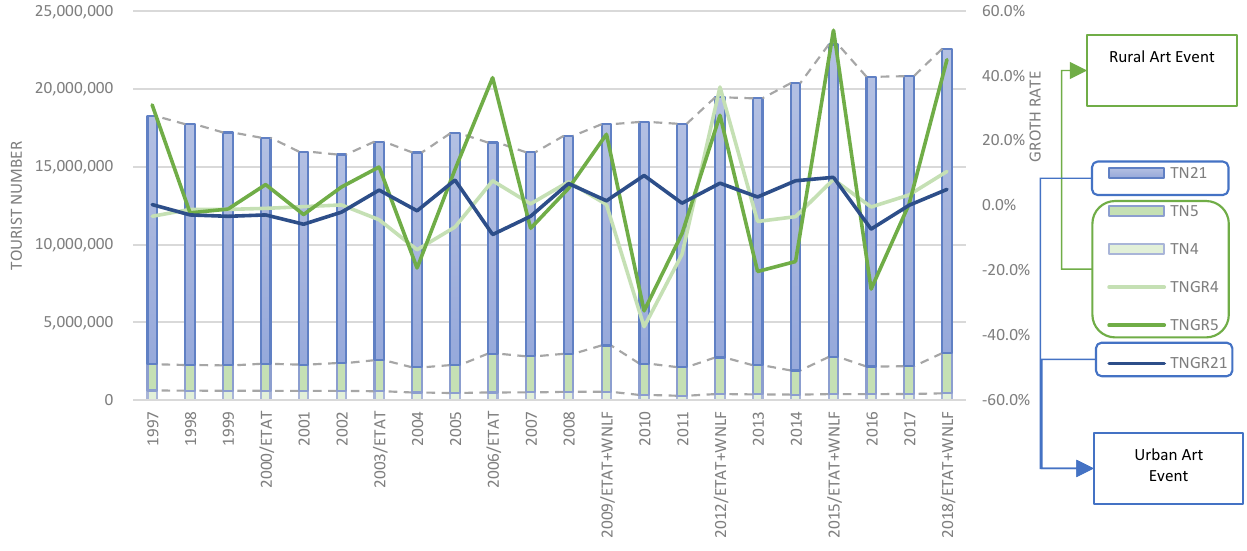
Figure 4. Tourist number and growth rate of the ETAT and WLNAF from 2000 to 2018 [10]. Figure 5 shows the economic ripple effect of ETAT and WLNAF from 2000 to 2018. Overall, the financial spread between 2000 and 2003 was the largest from the years